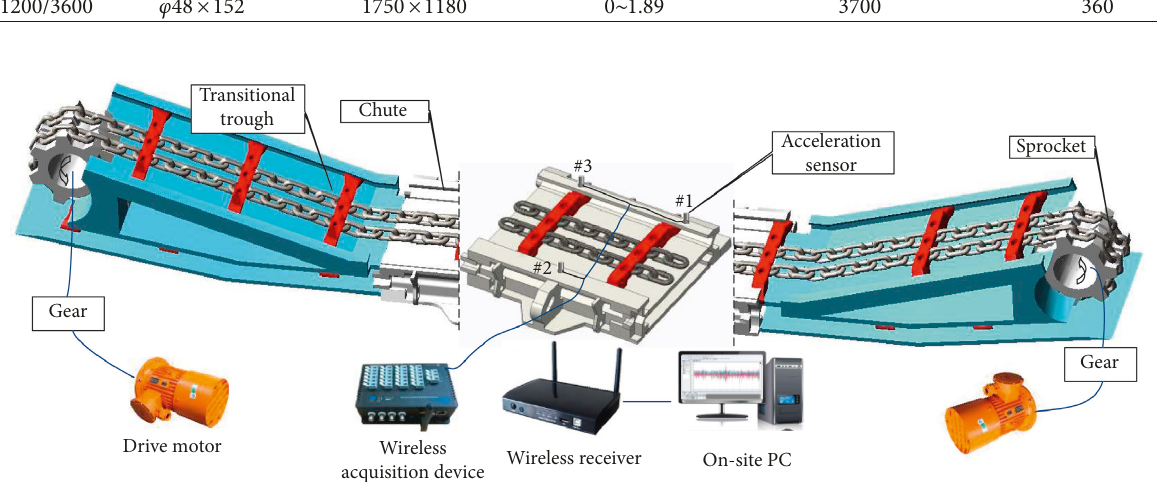
Figure 8: Experimental setup of the